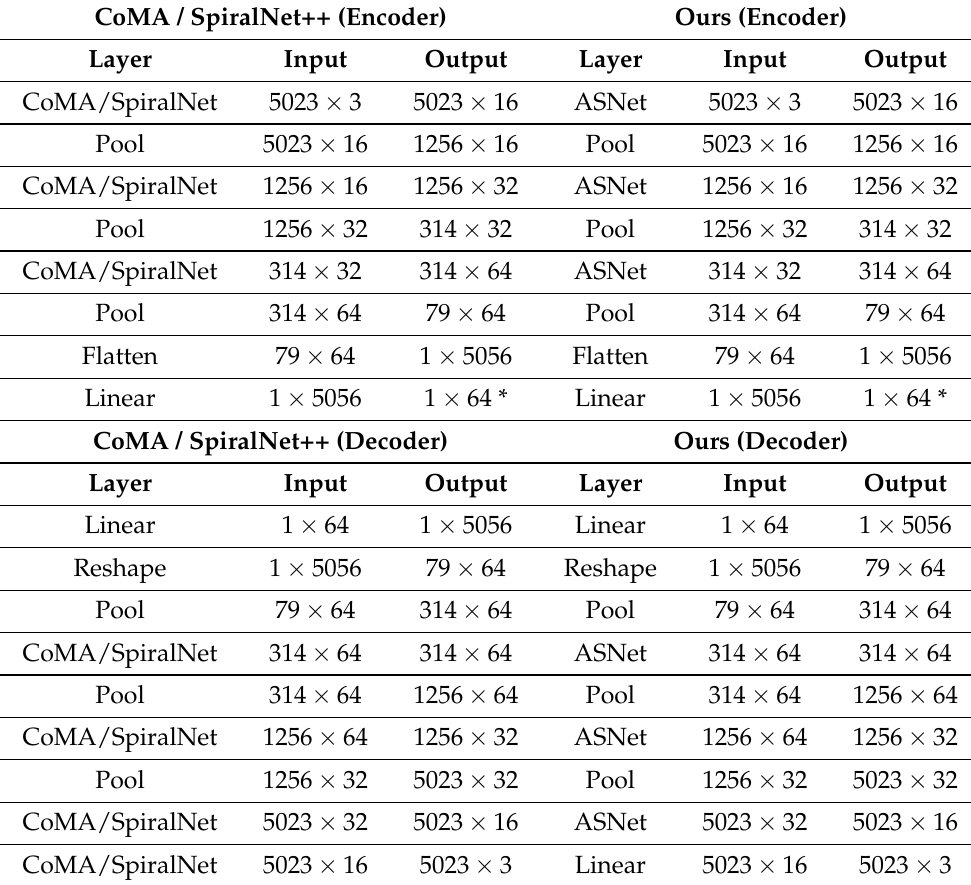
Table 1. The architectures of our network and other neural networks tested in this paper (CoMA and SpiralNet++) are shown in detail. Note that ASNet represents our anisotropic convolutional filter shown in Figure 4 and that the input and output shapes of each layer are identical across all networks. ∗ For variational autoencoder scheme, it requires two linear layers for mean ( µ ∈ R 64 ) and standard deviation ( σ ∈ R 64 ) .